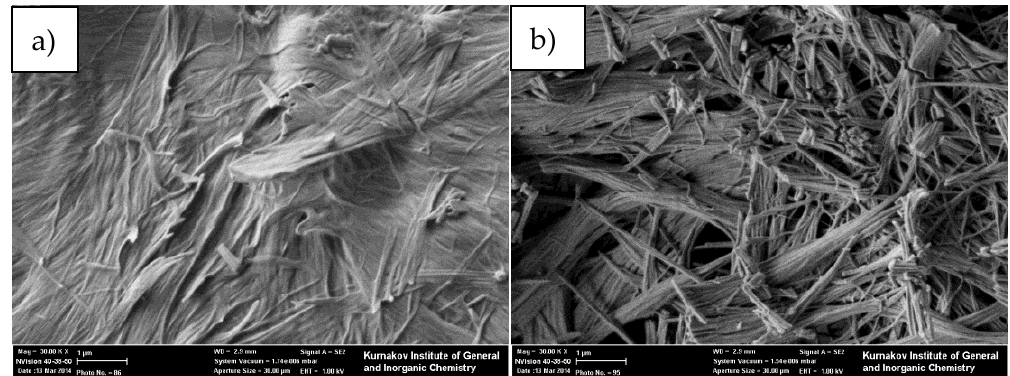
Figure 9. SEM micrographs of dry gel samples obtained by different solvent removal methods from benzene@4ce*HCl: ( a ) direct air-drying; ( b ) sc-CO 2 drying. Scale bar is 1 μ m.